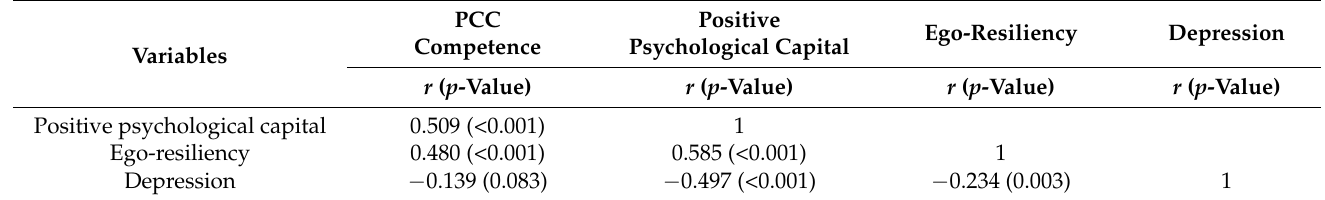
Table 2. Correlation between the main variables ( n =